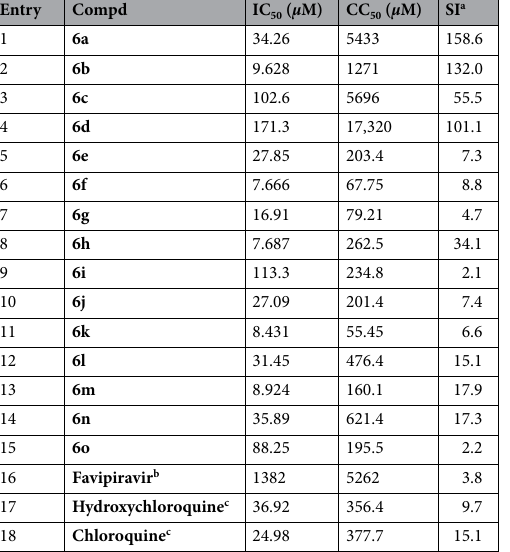
Table 5. Antiviral (SARS-CoV-2) properties of the synthesized spiro-3-indolin-2-ones 6a ‒ o and standard references. a SI = CC 50 /IC 50 . b Ref. 89 . c Ref. 51